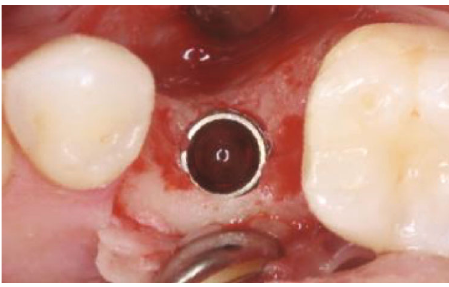
Figure 6: Implant placement after 4 months.